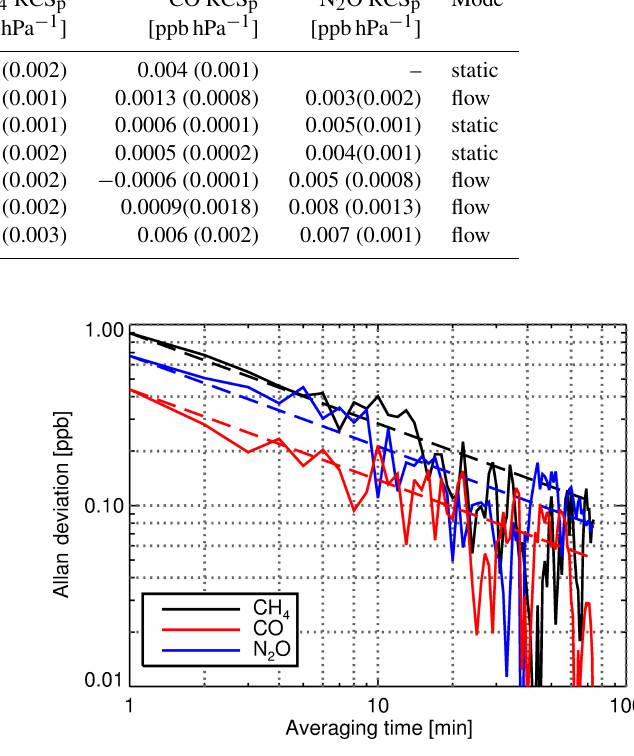
Figure 7. CH 4 , CO and N 2 O Allan deviations calculated from the February 2015 repeatability experiment. The data set consists of 170 consecutive 1min spectra acquired during measurement of the TC under standard operating conditions (cell pressure is 1100hPa, cell temperature is 33.85 ◦ C and flow rate is 0.5Lmin − 1 ). The dashed lines represent the Gaussian-noise-limited Allan deviation using the derived Allan deviation of the smallest temporal incre- ment (1min) as the